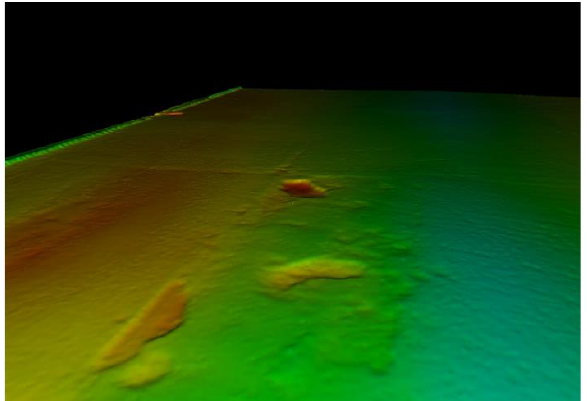
Figure 16 . 3D model of road surface with potholes.